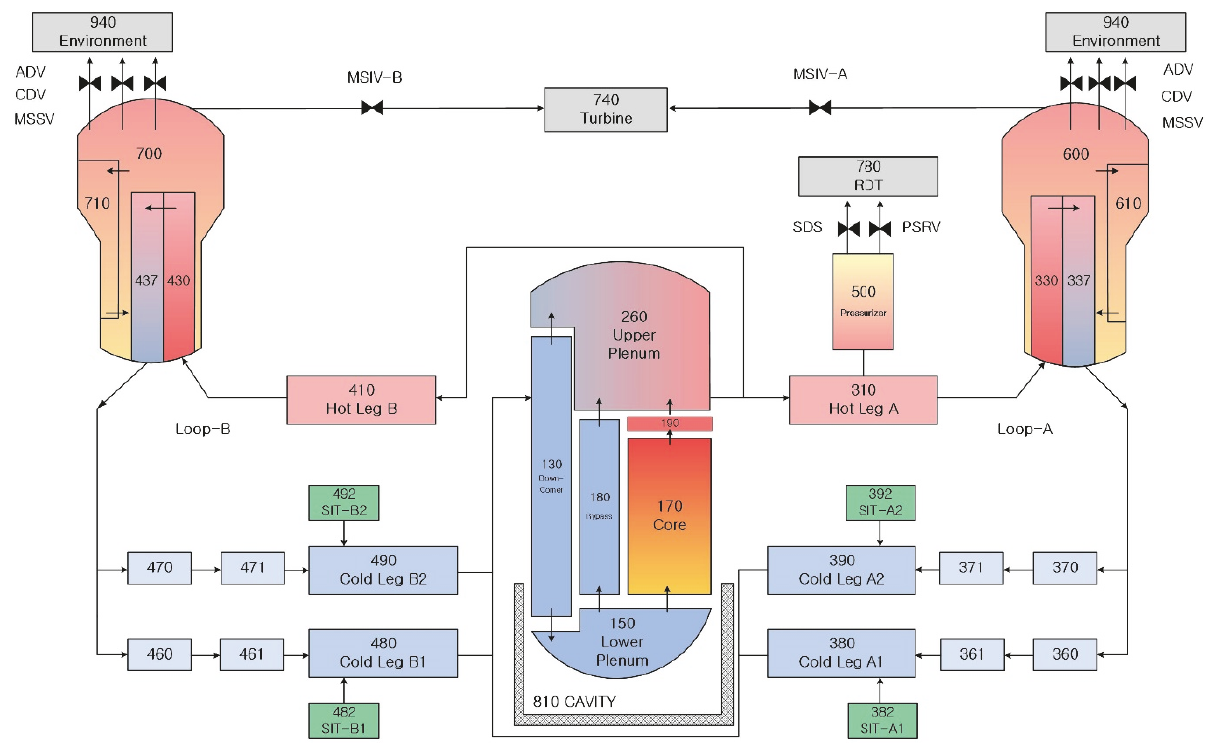
Figure 1: The nodalization of OPR1000 MELCOR input